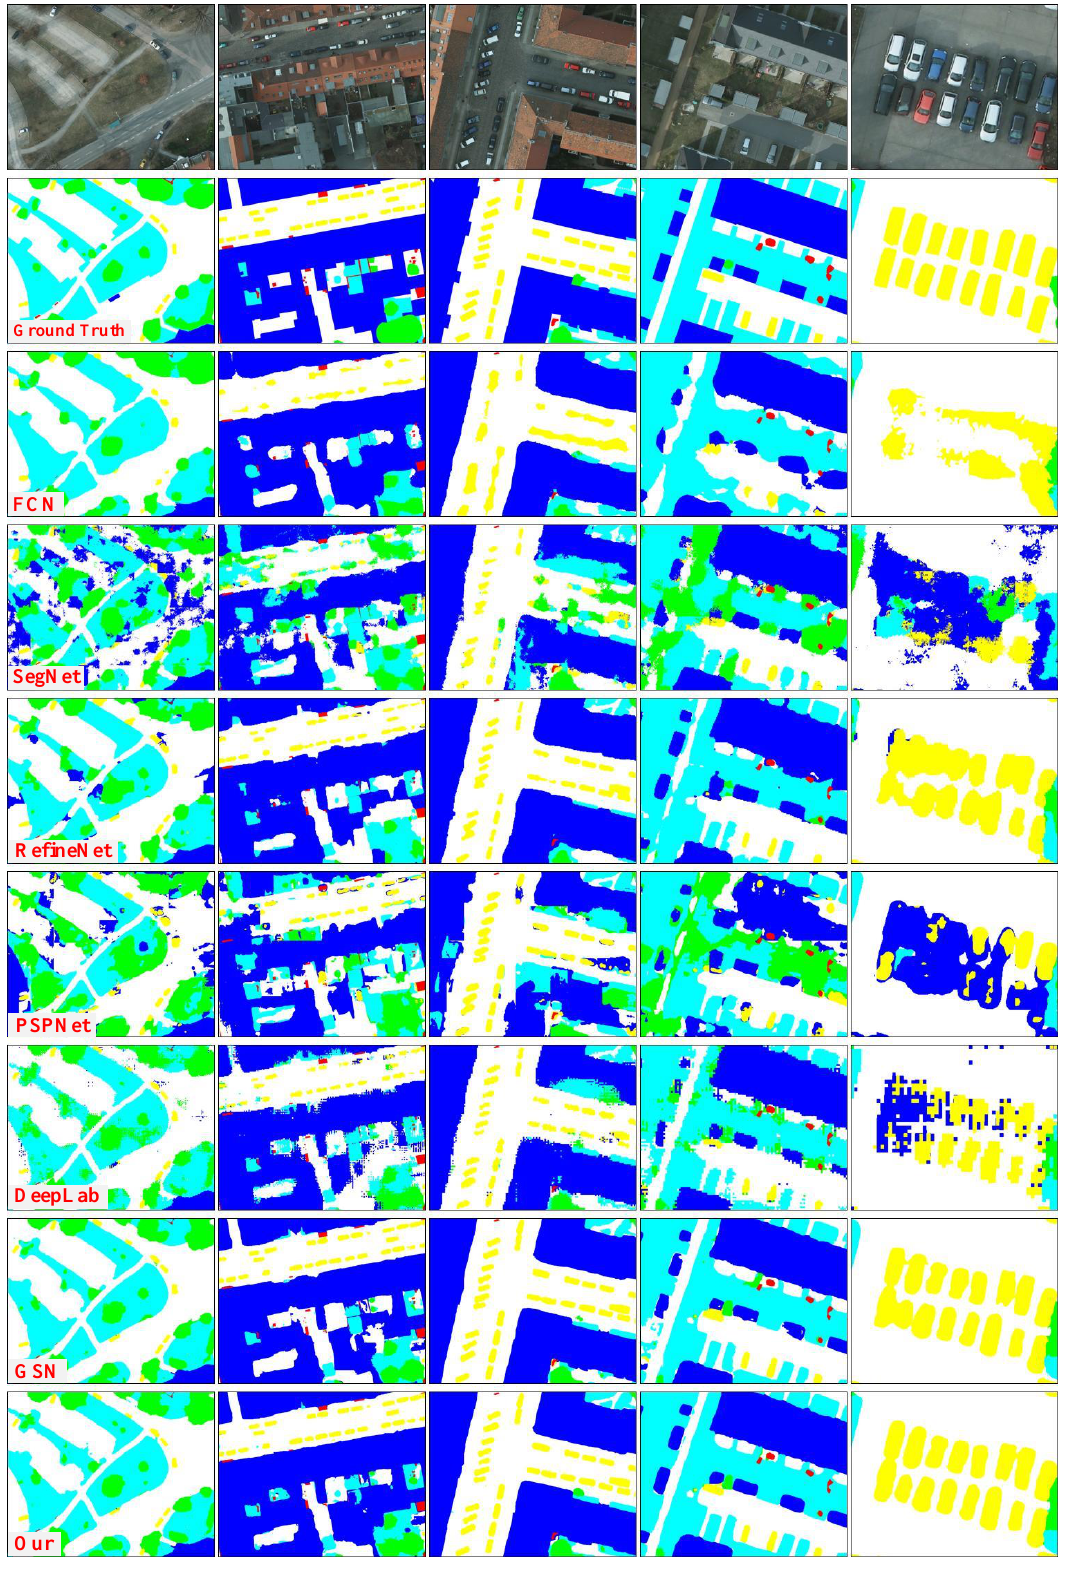
Figure 4. Visual comparisons between L-GCNN (ours) and other related methods on the Potsdam dataset. Label includes six categories: impervious surface (white), building (blue), low vegetation (cyan), tree (green), car (yellow) and clutter/background (red). Here, backgrounds are directly shown as they were considered as masks when training the